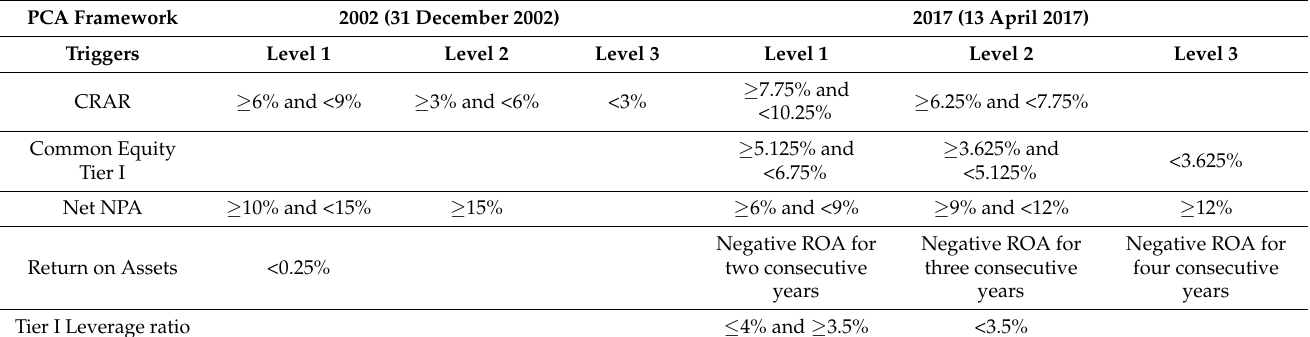
Table A2. PCA Framework—Financial